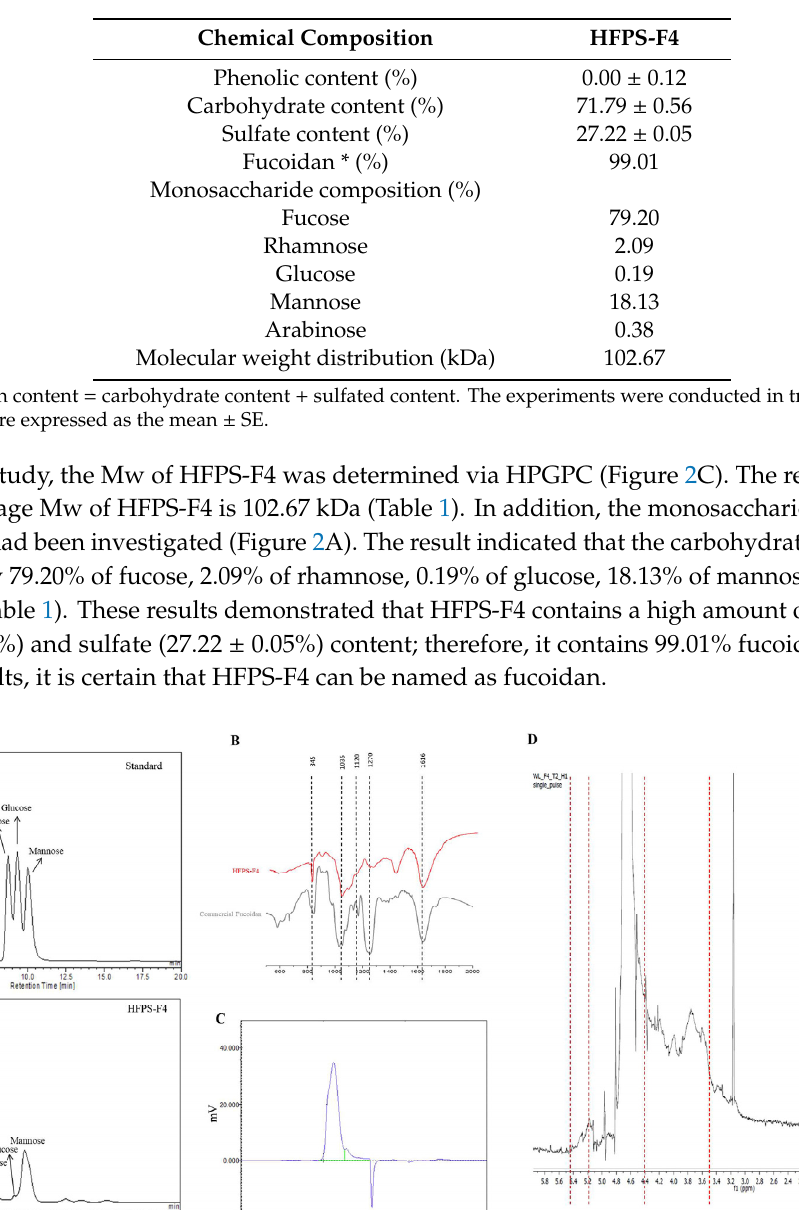
Table 1. The chemical composition of HFPS-F4.